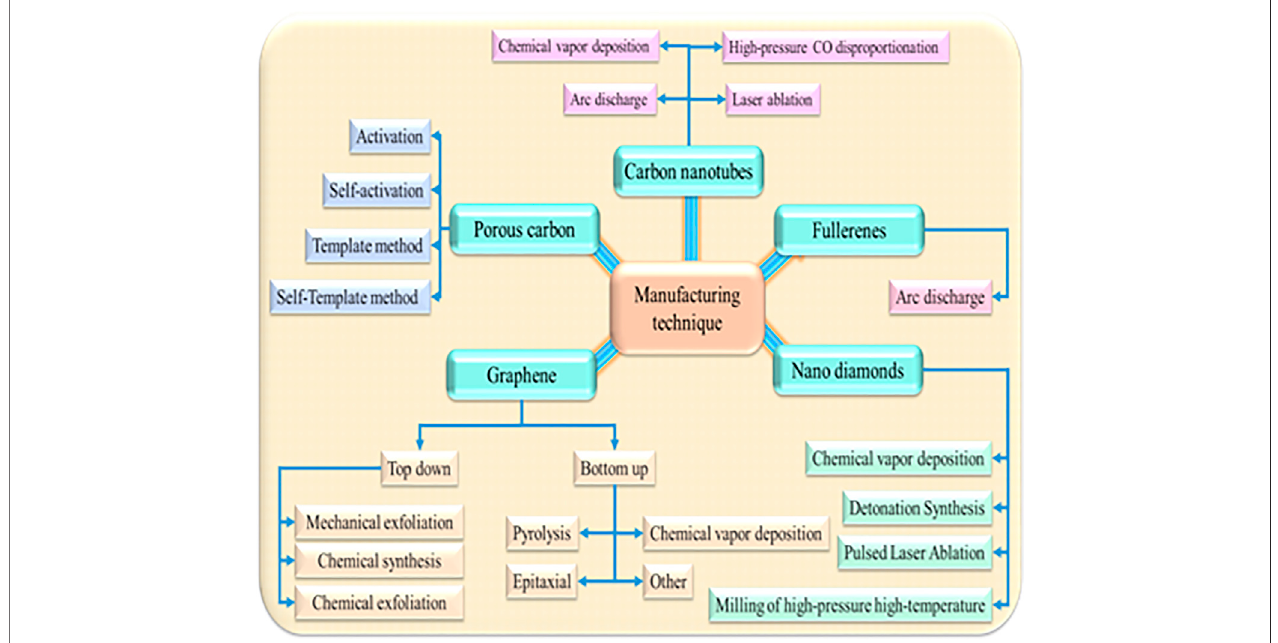
FIGURE 2 | Adoptable techniques for the synthesis of